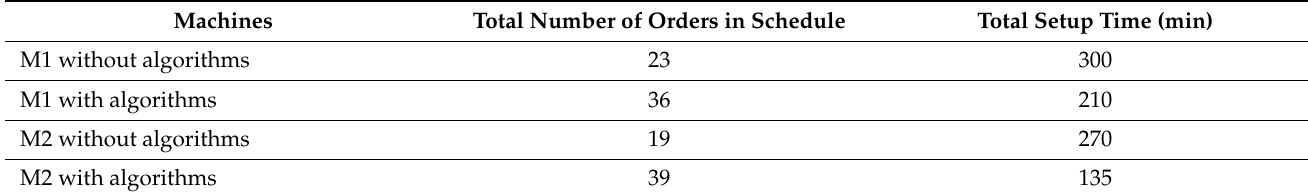
Figure 9. The overall performance of setup time for two machines. Table 6. The performance of schedule for each machine in the two machines’ test. Table 6. The performance of schedule for each machine in the tw o machines’ test .